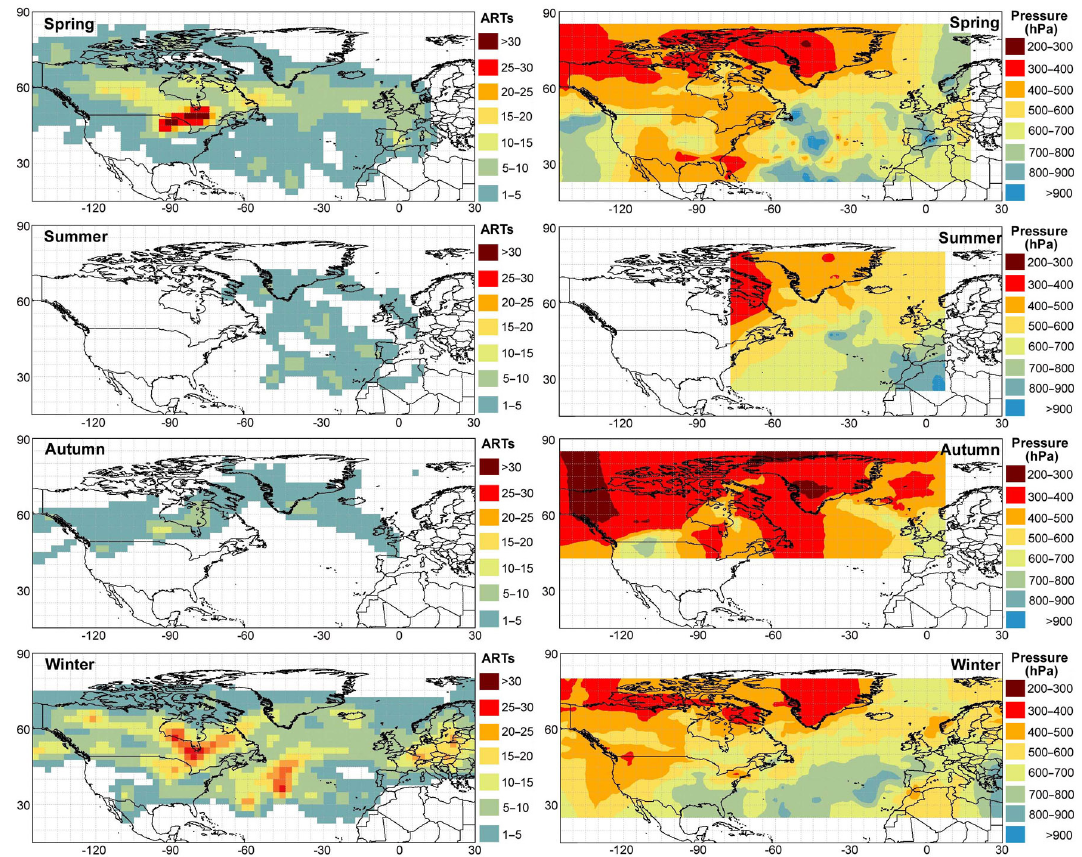
Figure 8. Air mass residence times (ARTs) and averaged pressure of air masses associated with high PBM events for each season during the study